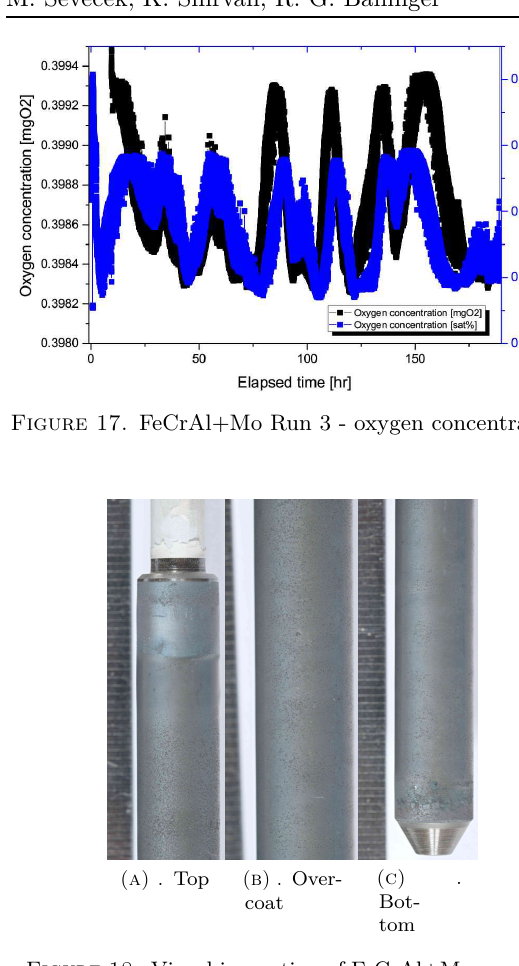
Figure 18. Visual inspection of FeCrAl+Mo pressure tubes after Run 1, Run 2 and Run 3 - tension.